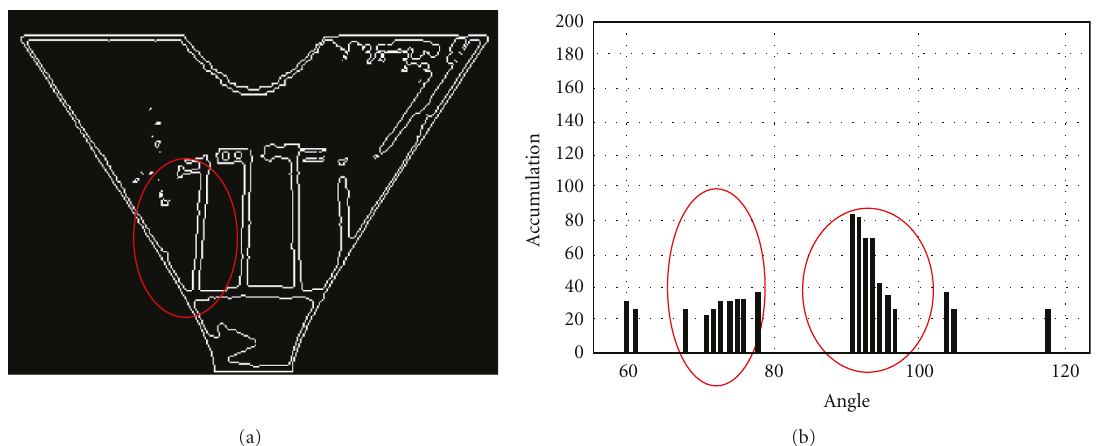
Figure 16: Illustrative figures of the trapezoid histogram distributions. (a) The figure of lane markings. (b) The trapezoid